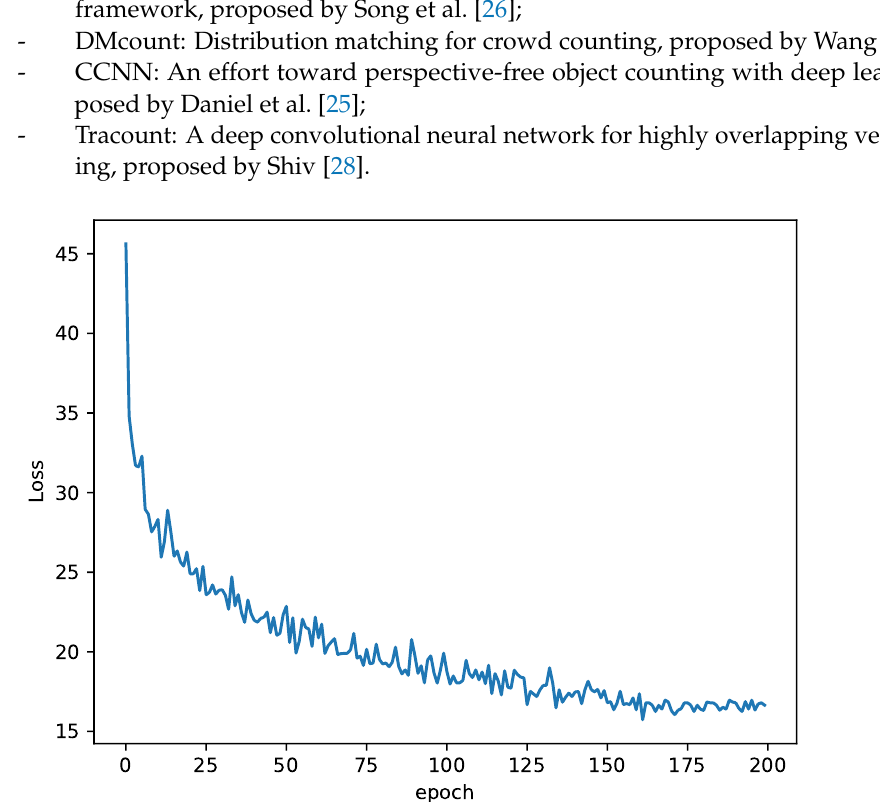
Figure 4. Illustration of the convergence speed of the